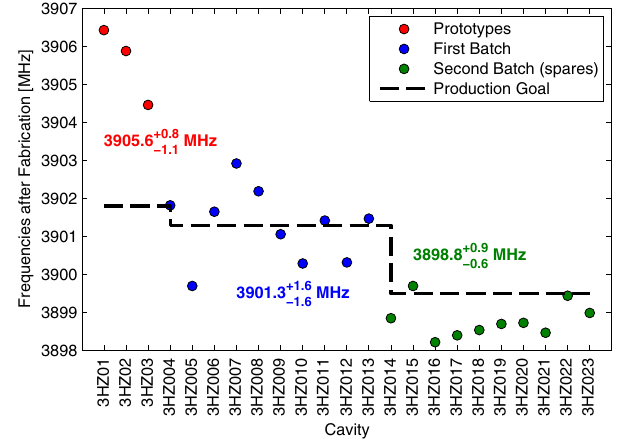
FIG. 6. Frequencies of the cavities after mechanical fabrication, for the three production batches. In the labels the averages and the uncertainties of the frequencies measured in each production batch. The dashed black line shows the production goal, which was revised in the cavity frequency preparation procedure after each iteration pass with the better knowledge of the fabrication and treatment parameters and cavity responses.